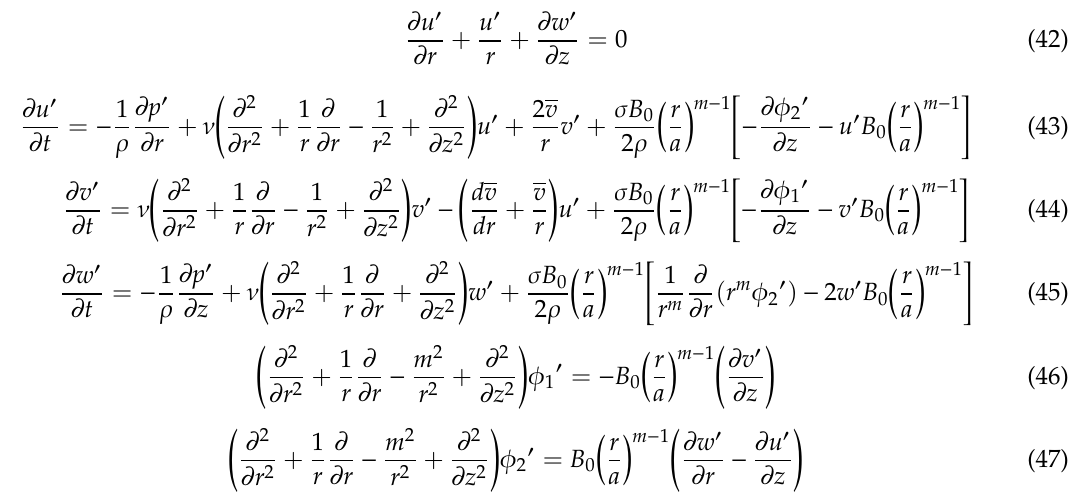
Figure 4. The azimuthal velocity gradient of the basic flow at the axis of cylinder for the three numbers of the pole-pairs.